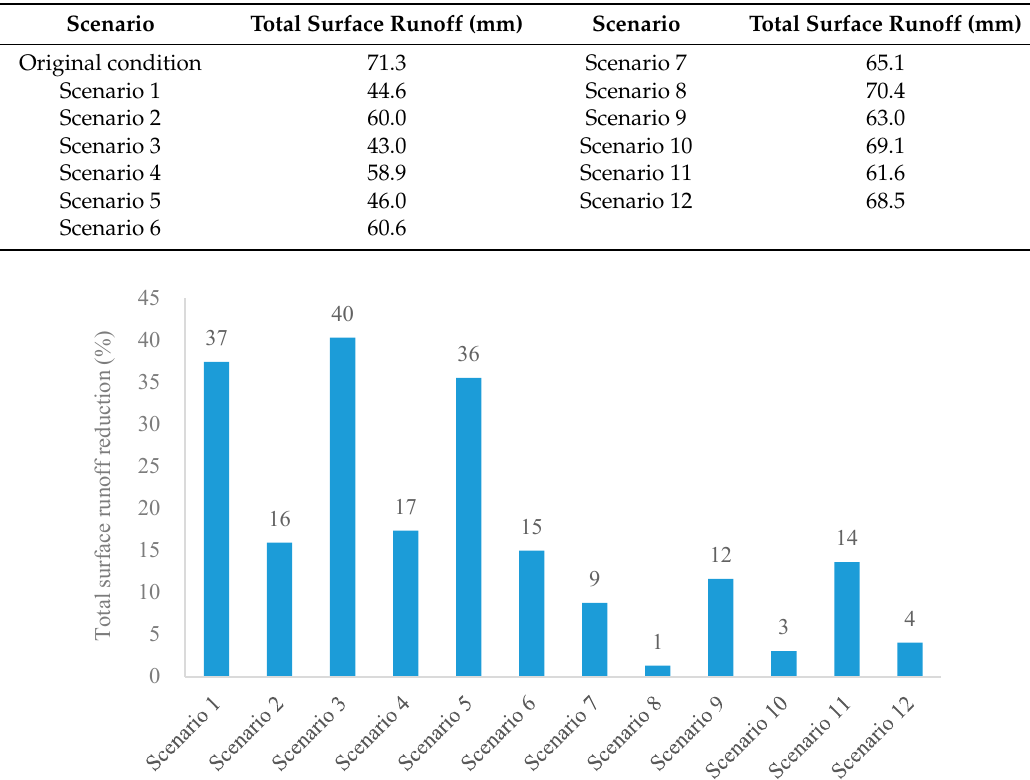
Table 5. Total 12-h surface runoff under original condition and all scenarios.